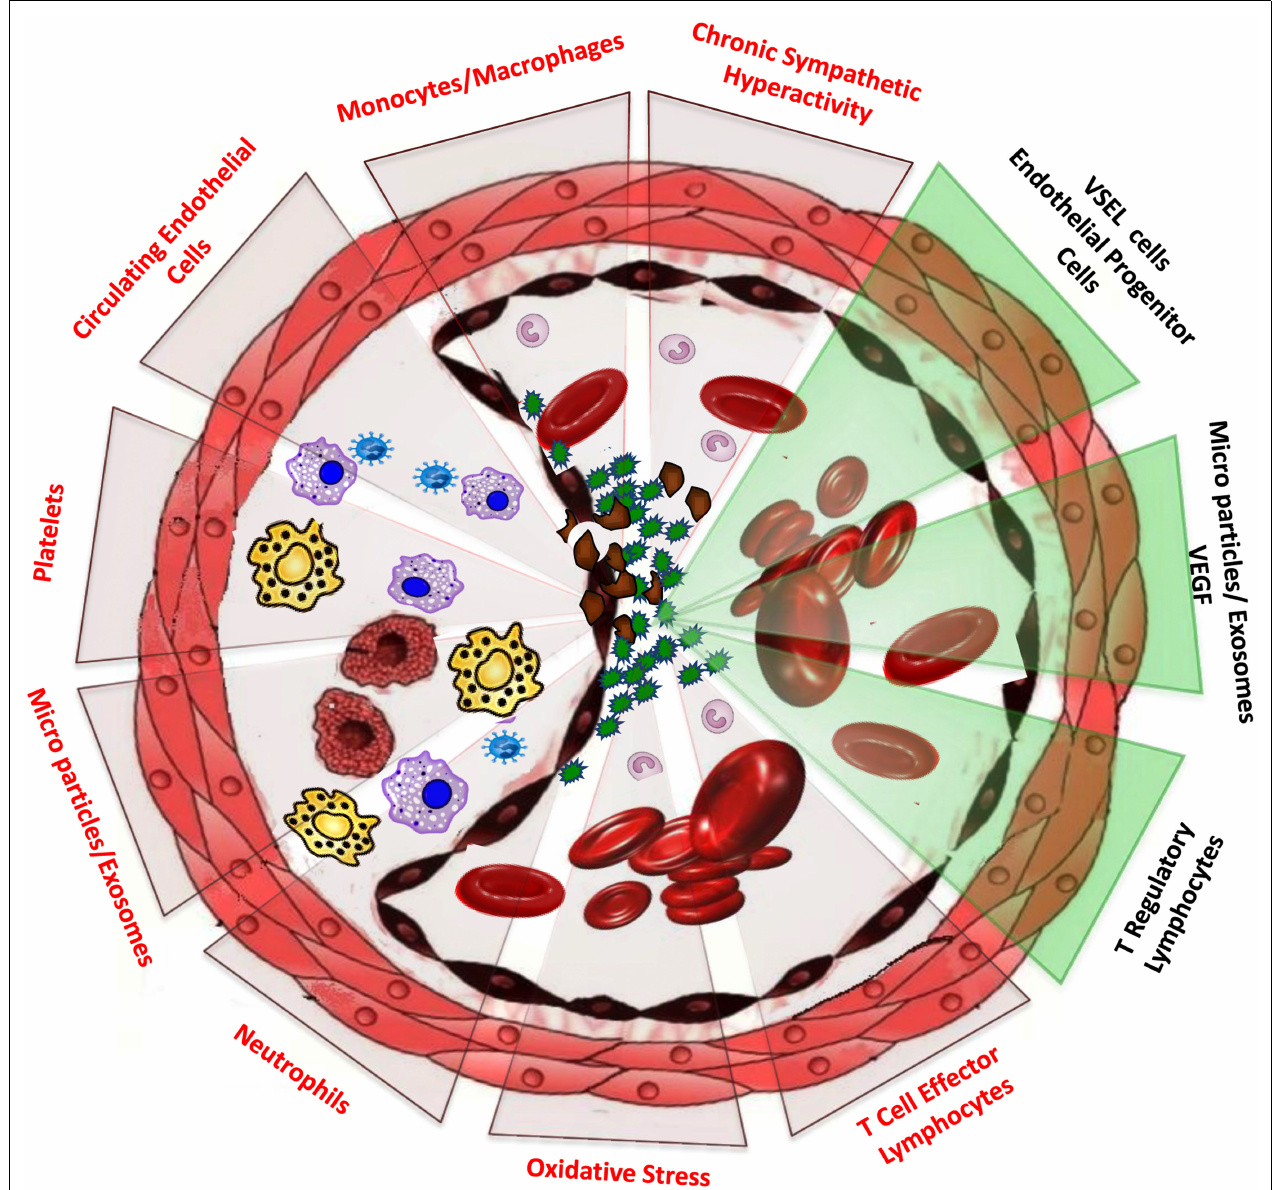
release of a variety of chemokines and pro-angiogenic agents, such asVEGF may be prompted by some subsets of cell-derived microparticles or exosomes, and may lead to recruitment, migration, and homing to the damaged endothelium of multiple sub-populations of bone marrow resident stem cells that have the potential to repair the injured endothelium and either mitigate or induce a regain of vascular function (green background